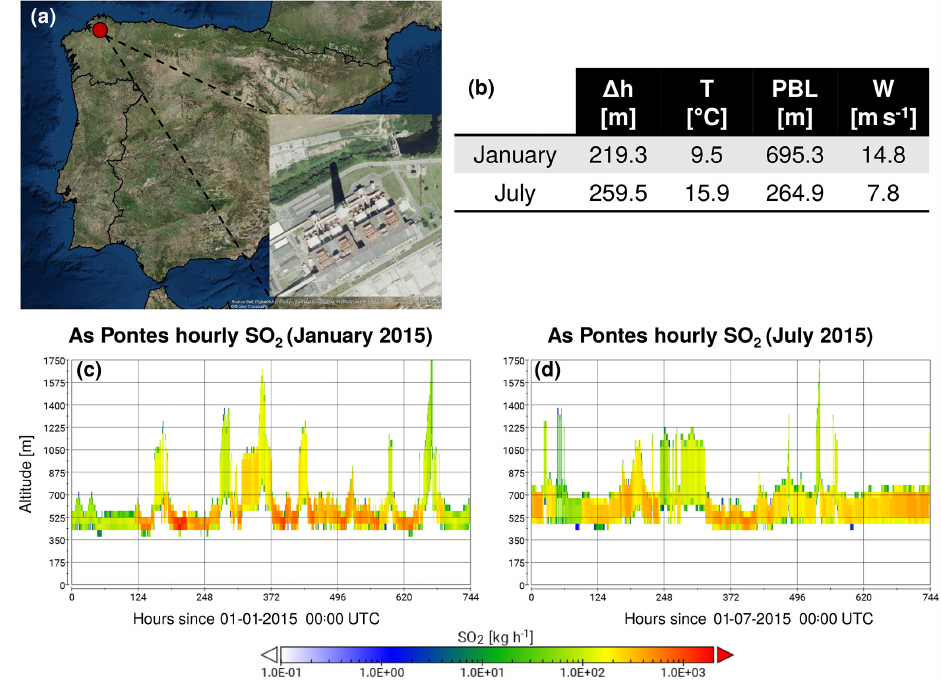
Figure 4. (a) Location of the As Pontes Spanish coal-fired power plant (sources of the ArcGIS Online basemap: Esri, DigitalGlobe, GeoEye, i-cubed, USDA FSA, USGS, AEX, Getmapping, Aerogrid, IGN, IGP, swisstopo and the GIS user community); (b) modelled average plume thickness ( (cid:49)h ) (m), air temperature at the stack height ( T ) ( ◦ C), boundary-layer height (planetary boundary layer, PBL) (m) and wind speed at the stack height ( W ) (ms − 1 ) for January and July (monthly averages); results of the hourly and vertically distributed SO 2 emissions (kgh − 1 ) estimated by HERMESv3_BU for the months of (c) January and (d) July 2015. The map in (a) was created using ArcGIS ® software by Esri. ArcGIS ® and ArcMap™ are the intellectual property of Esri and are used herein under license. Copyright © Esri. All rights reserved. For more information about Esri ® software, please visit https://www.esri.com (last access: February